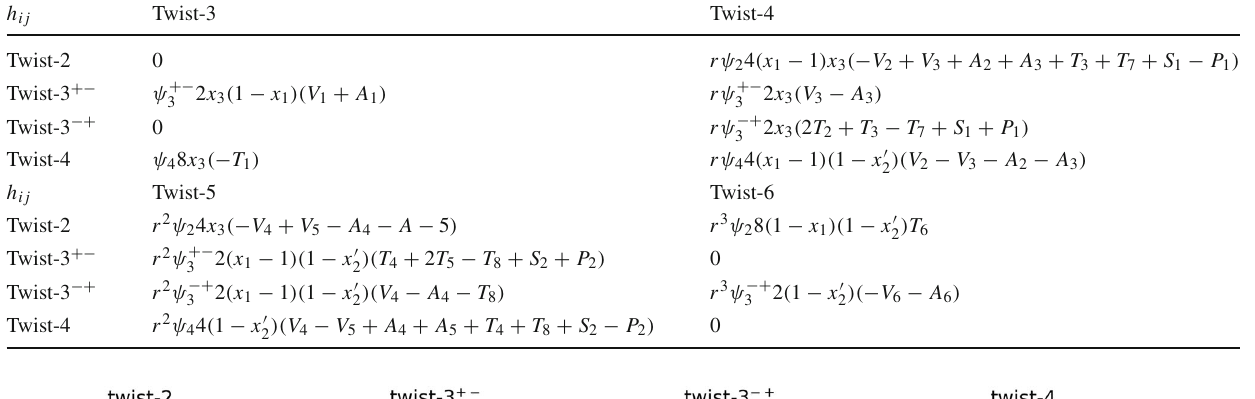
Table5 Numerators h ij oftheintegrandsinthefactorizationformulafortheformfactor f 1 ( 0 ) fromthediagram D 7 inFig.1with i = 2 , 3 +− , 3 −+ , 4 and j = 3 , 4 , 5 , 6. An overall coefficient C m 3 (cid:2)